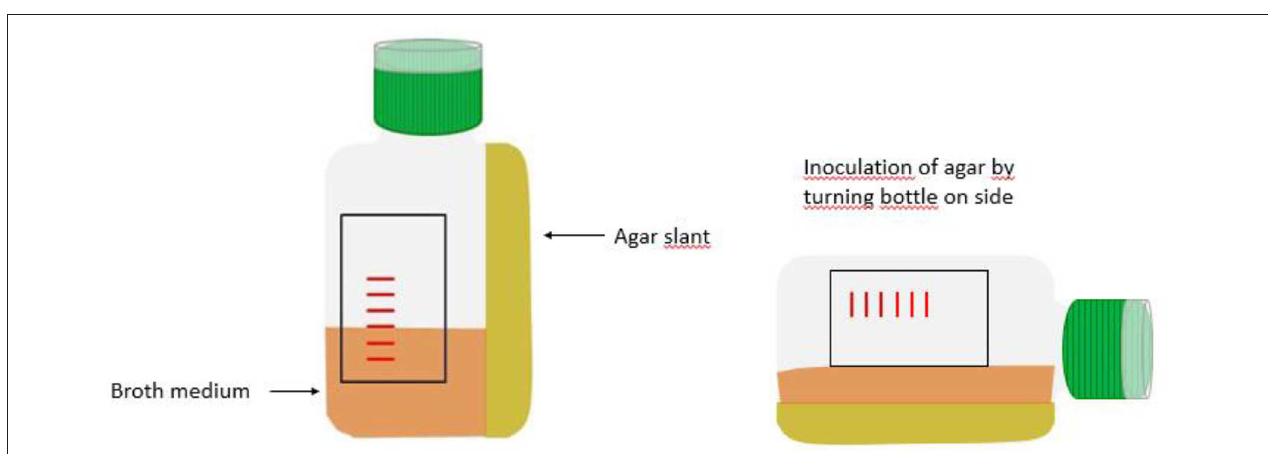
FIGURE 5 | Schematic representation of biphasic